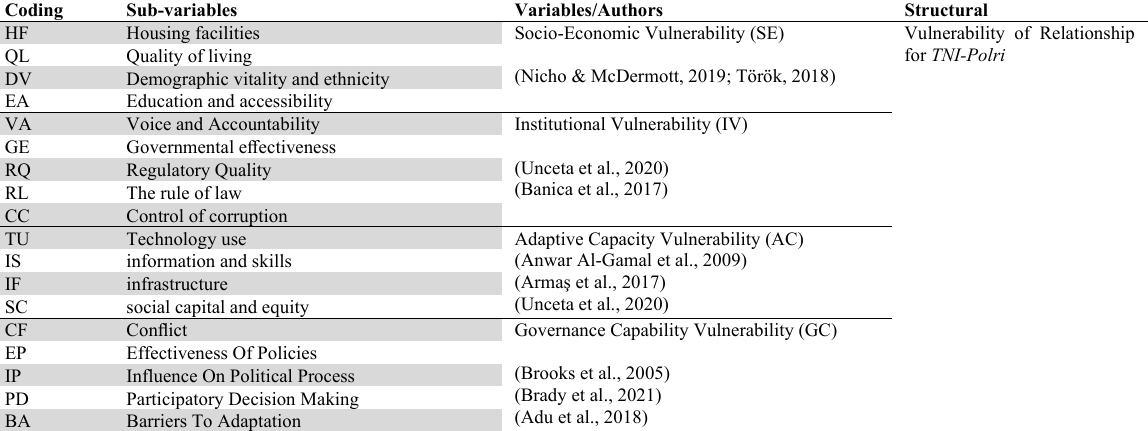
Selected Variables for relationship Vulnerability assessment between TNI-Polri